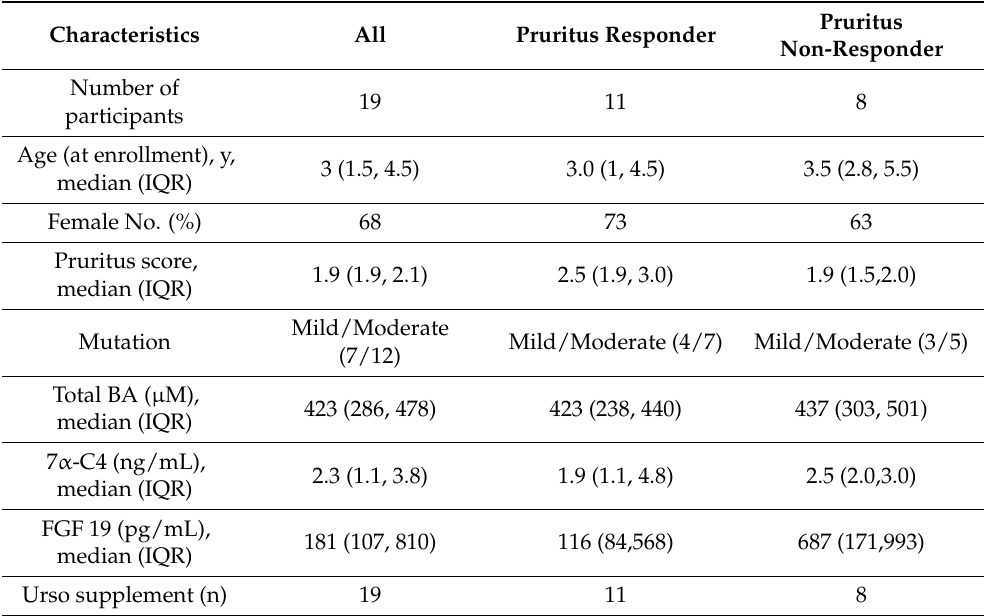
Table 1. Baseline characteristics of PFIC patients with prognostic groups in pruritus response under MRX treatment